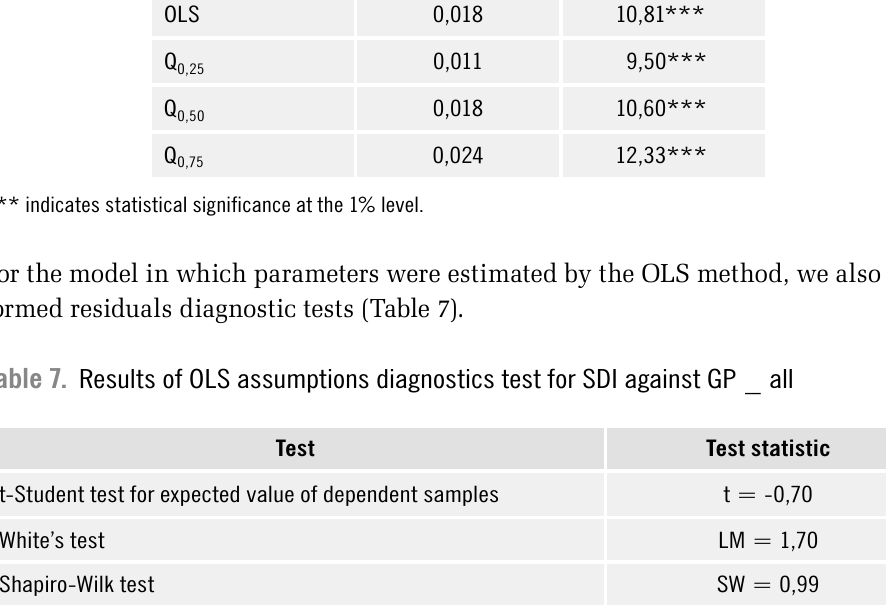
Table 6. OLS and quantile estimation of simple regression of SDI against GP _ all Estimator Parameters t-test